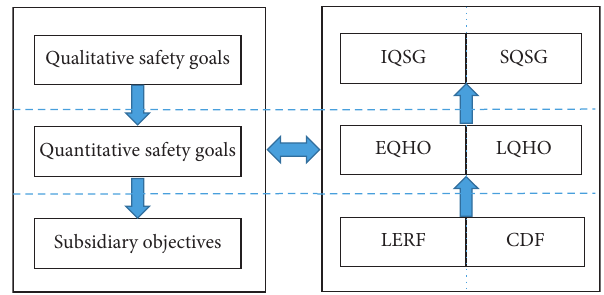
Figure 2: The relationship among nuclear safety goals in the